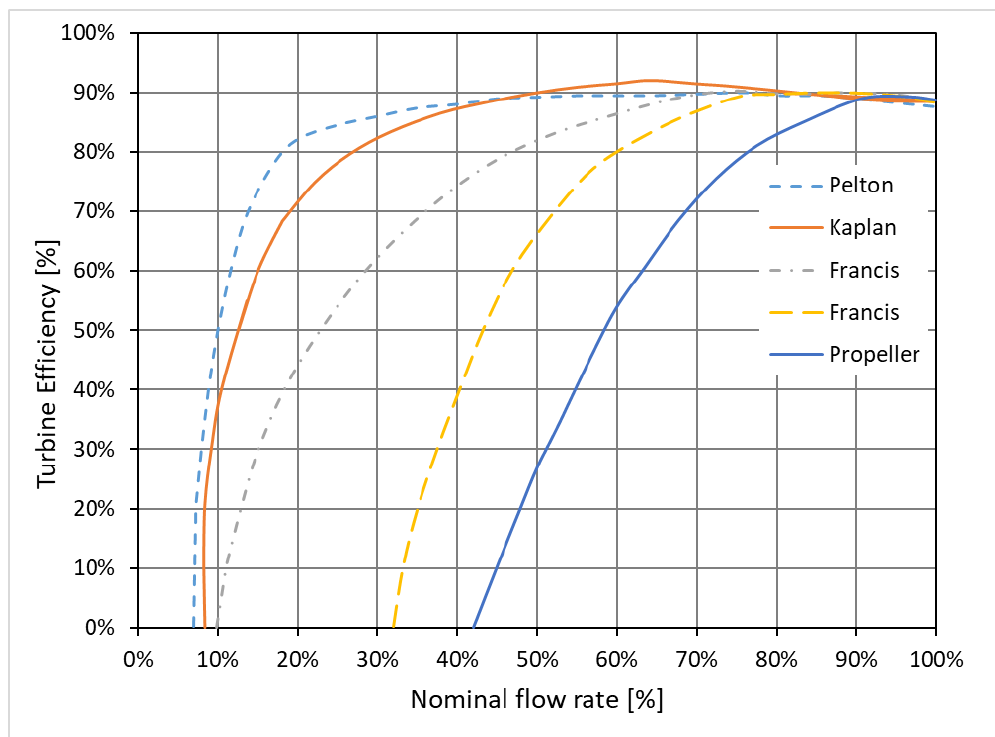
Figure 7. Turbine efficiency vs. flow rate%.